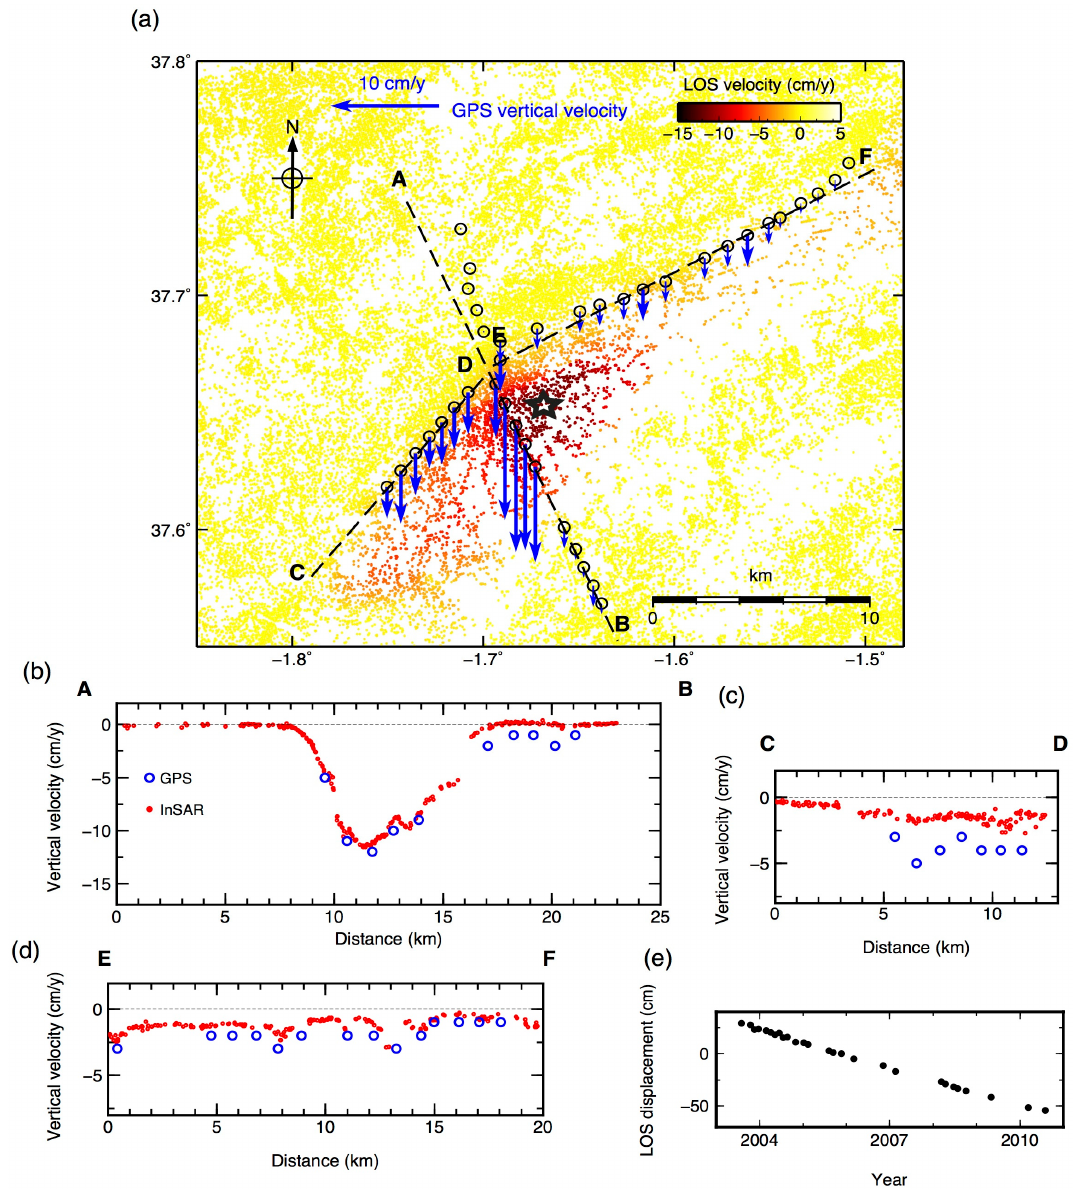
Figure 2. ( a ) Deformation map from ENVISAT data for the time period 2003–2010 (Box A in Figure 1a). Negative deformation (red regions) indicates land subsidence. Black circles show the GPS location, and blue arrows indicate GPS vertical velocities. GPS velocities are obtained by comparing the reference vertical positions provided by the IGNE, which varies in the network between August–September 2004 and March 2009 (see Figure 1b), and the new vertical positions measured in 2013 (see Table S1). The large blue arrow at the top represents the scale of GPS velocities. ( b – d ) Cross-sections showing vertical deformation rates from InSAR (red dots) and GPS data (blue circles) measured along the three dashed black lines in ( a ). ( e ) LOS time series for the point indicated by the black star in ( a ). Figure 2b–d shows the comparison of vertical deformation rates from GPS and InSAR